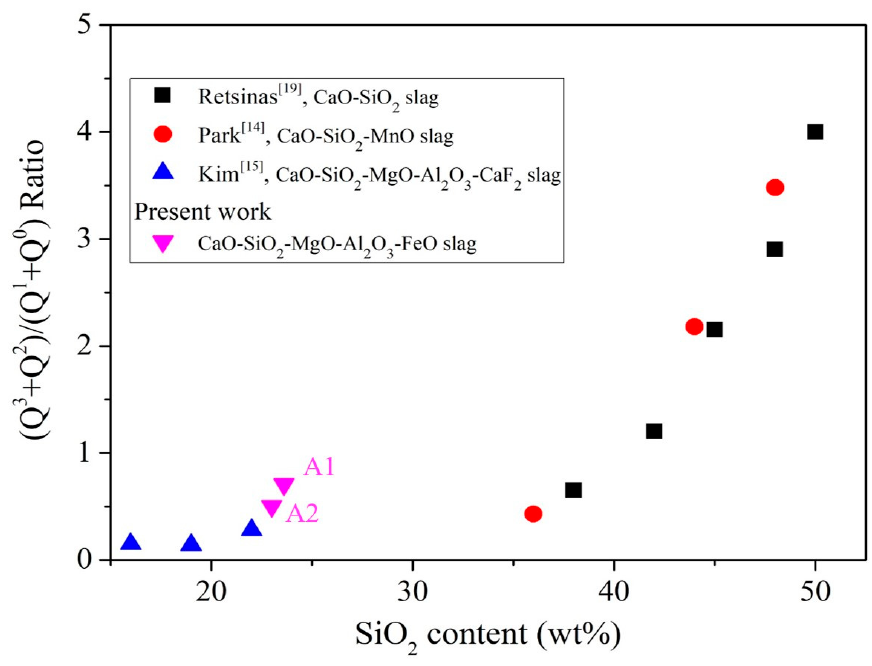
Figure 8. Influence of SiO 2 content on Q 2 + Q 3 / Q 0 + Q 1 of liquid slag [14,15,19].